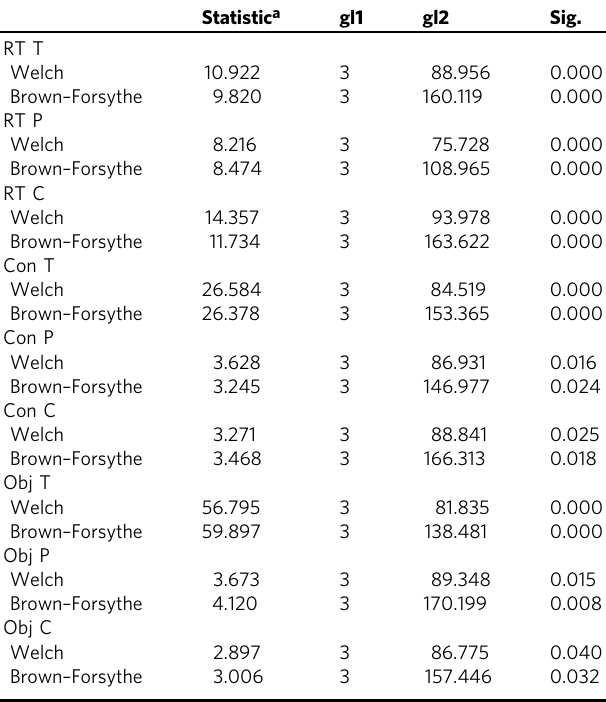
history class (Section